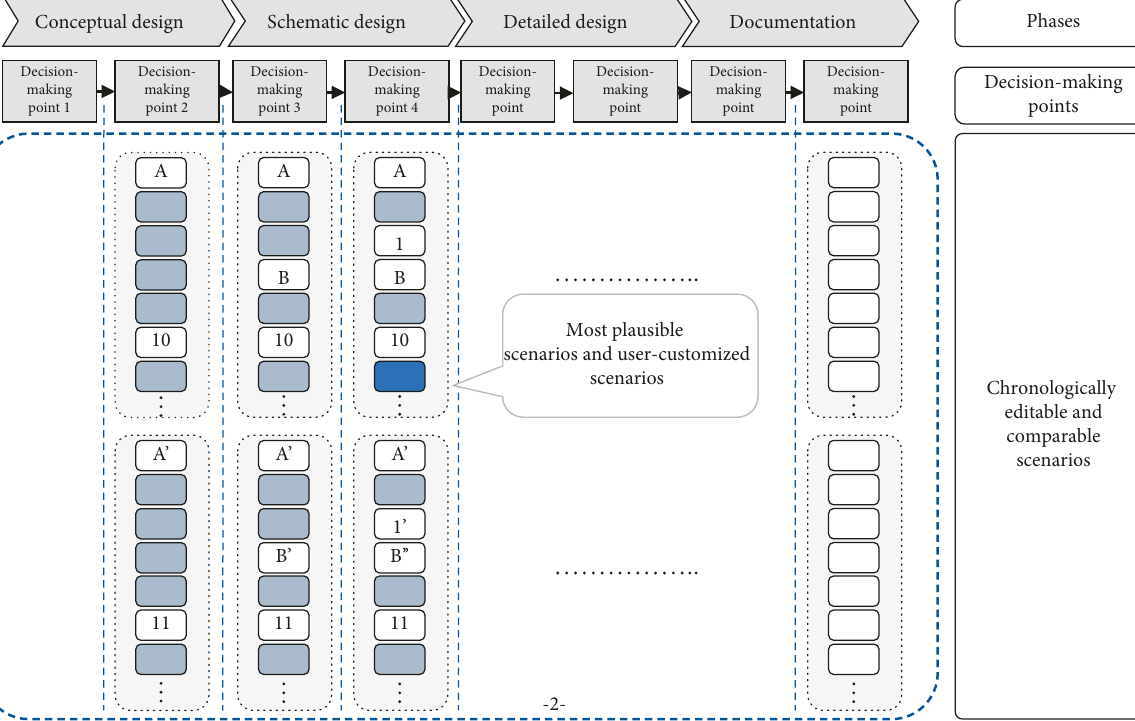
Figure 3: Opportunities to apply scenarios.